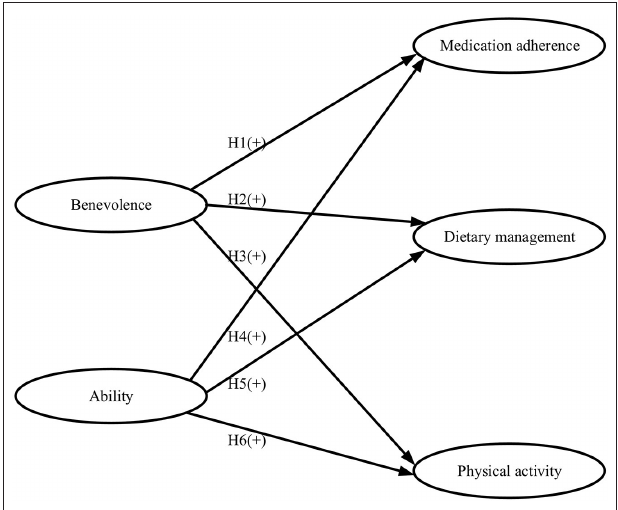
FIGURE 1 | Structural framework of hypothesized